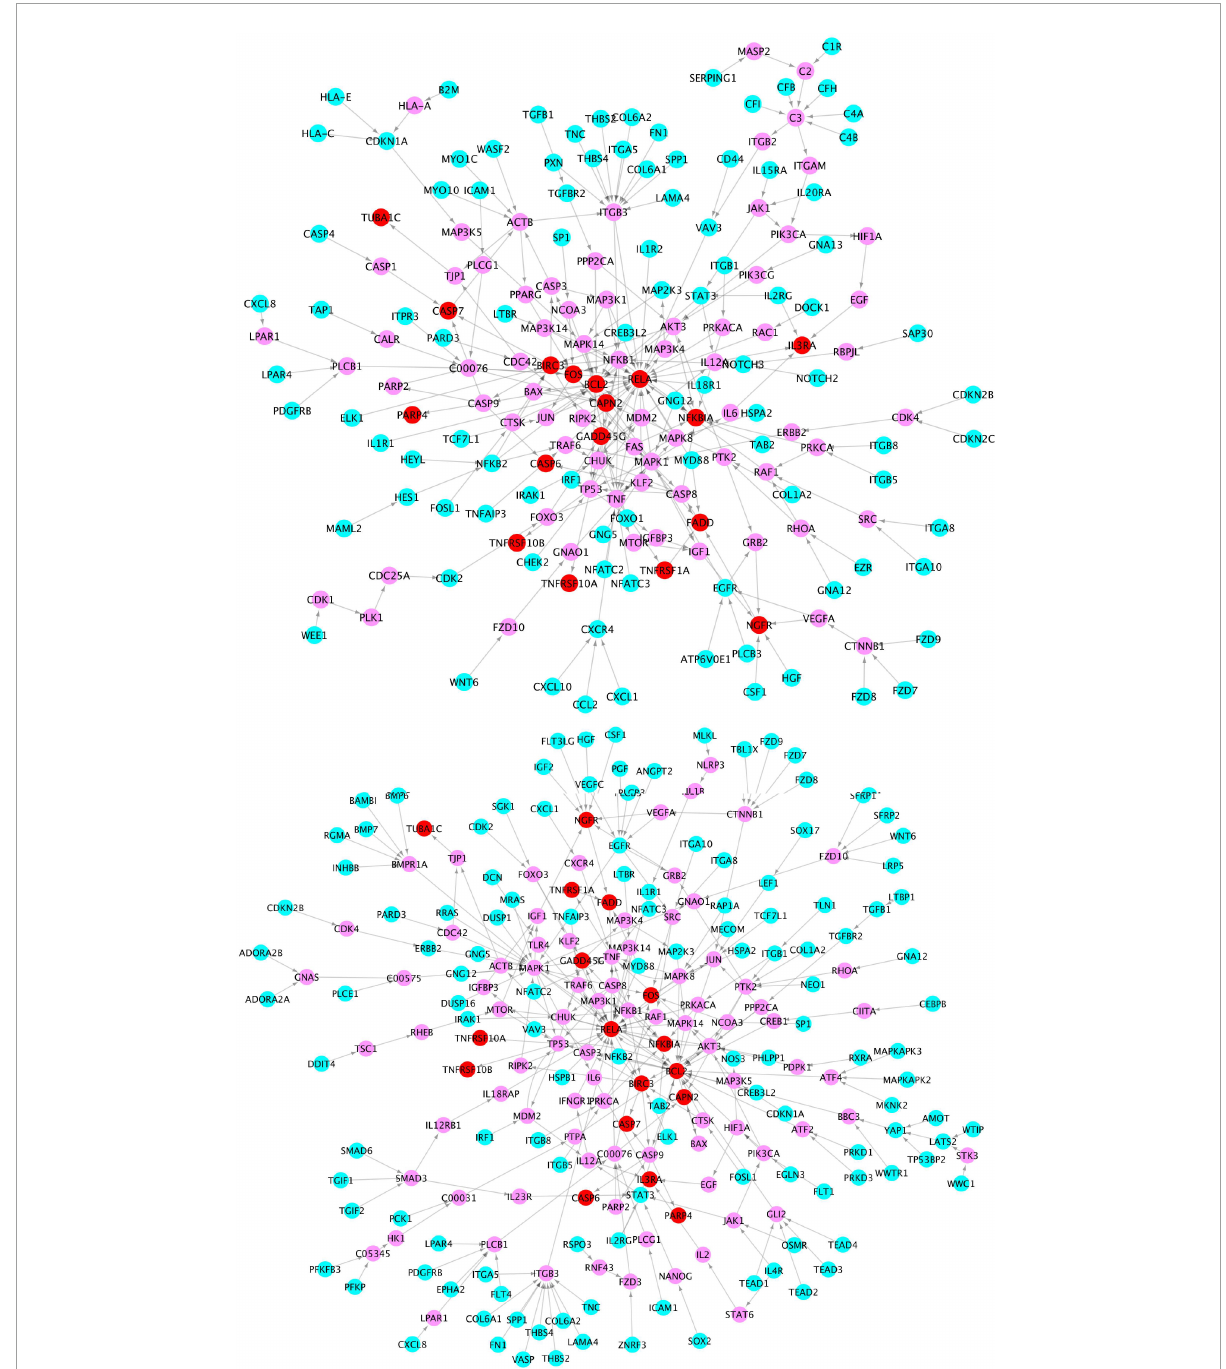
FIGURE5 Signaling cascades that links the upregulated genes in the virus infection pathways (cyan) (top) and x-core signaling pathways (bottom) , respectively, to the upregulated apoptosis signaling genes (red) via the linking genes (pink).